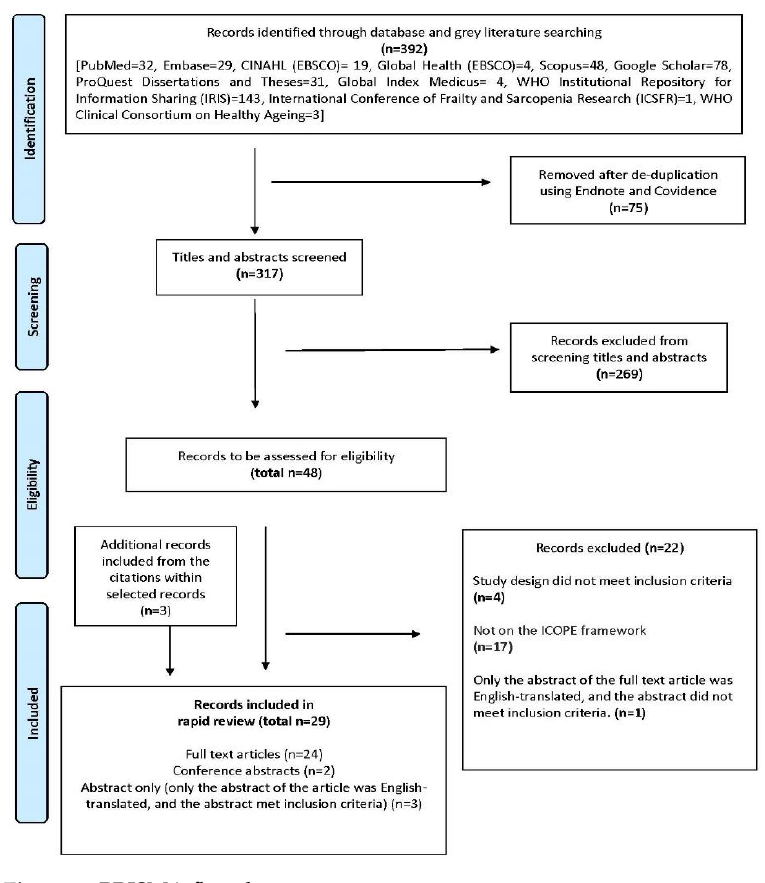
Figure 2. PRISMA flowchart.